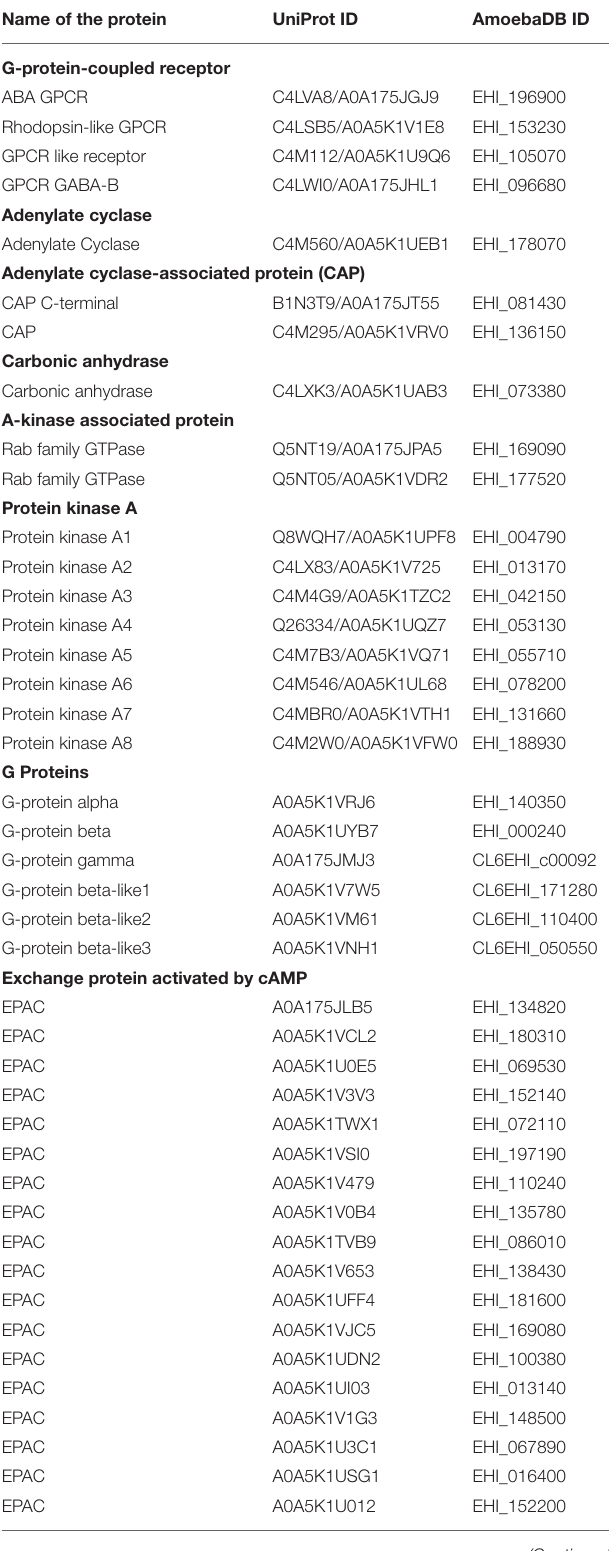
TABLE 1 | List of all the elements of the cAMP signaling pathway identified from E. histolytica . Name of the